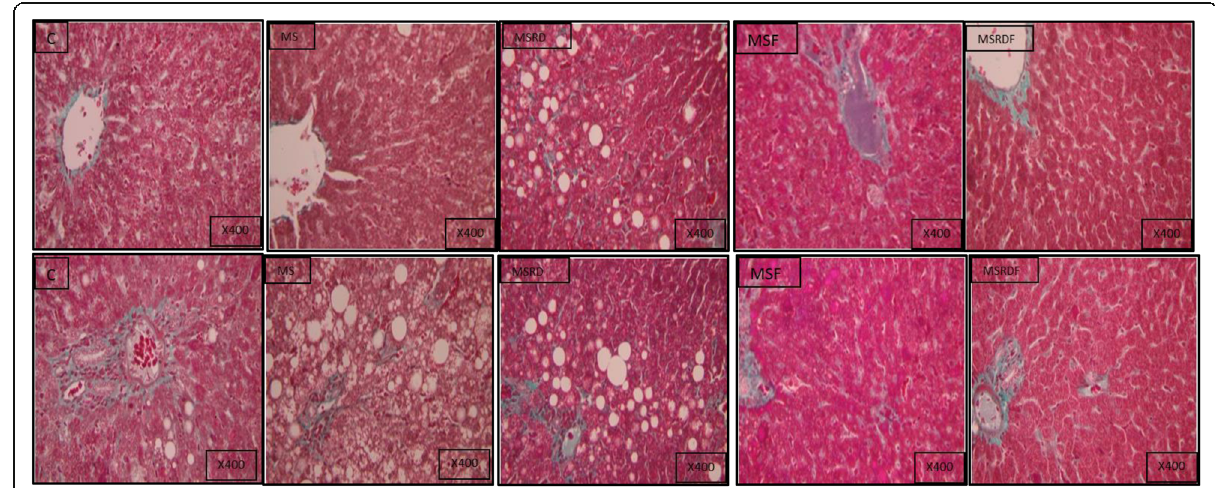
Fig. 10 Liver tissue photomicrograph of the five study groups after 12 weeks (MTS). C control group, MS untreated metabolic syndrome group, MSRD metabolic syndrome group reverted to regular rat chow, MSF metabolic syndrome group on alternate day fasting, MSRDF metabolic syndrome group reverted to regular rat chow and on alternate day fasting